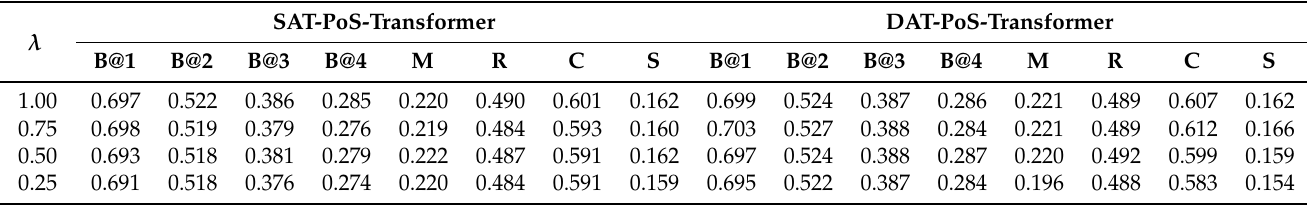
Table 3. The performance of PoS-Transformer with different values of hyperparameter λ on Flickr30k